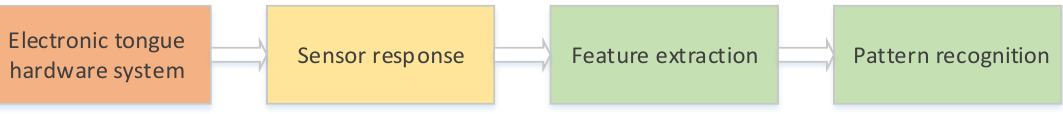
Figure 1. The basic flow of the electronic tongue system for liquid detection.